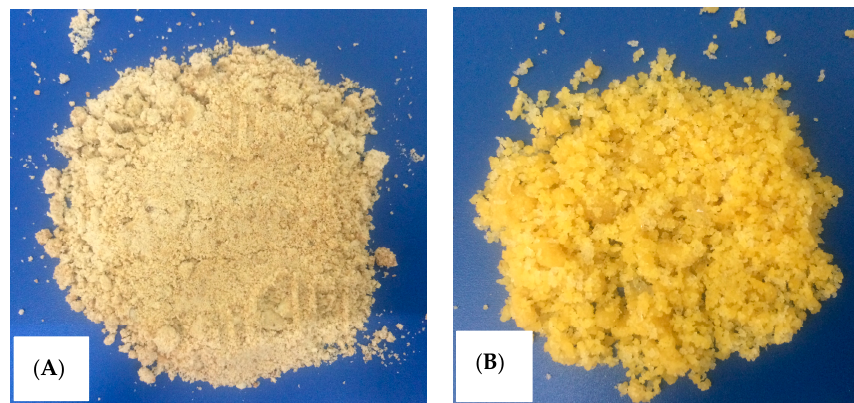
Figure 2. Photos of ( A ) milled Moringa seeds, and ( B ) synthesized protein.